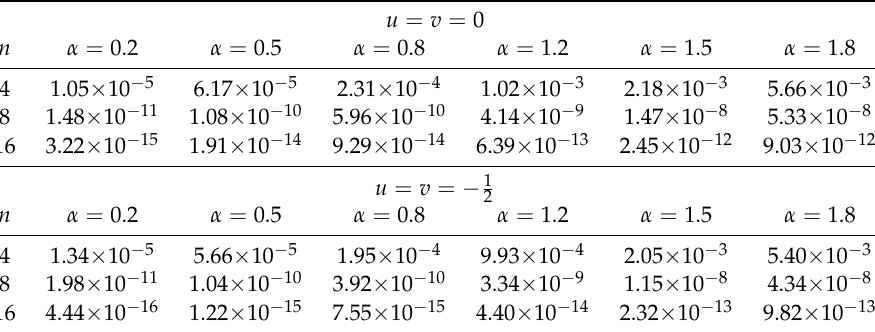
Table 9. The absolute errors for Example